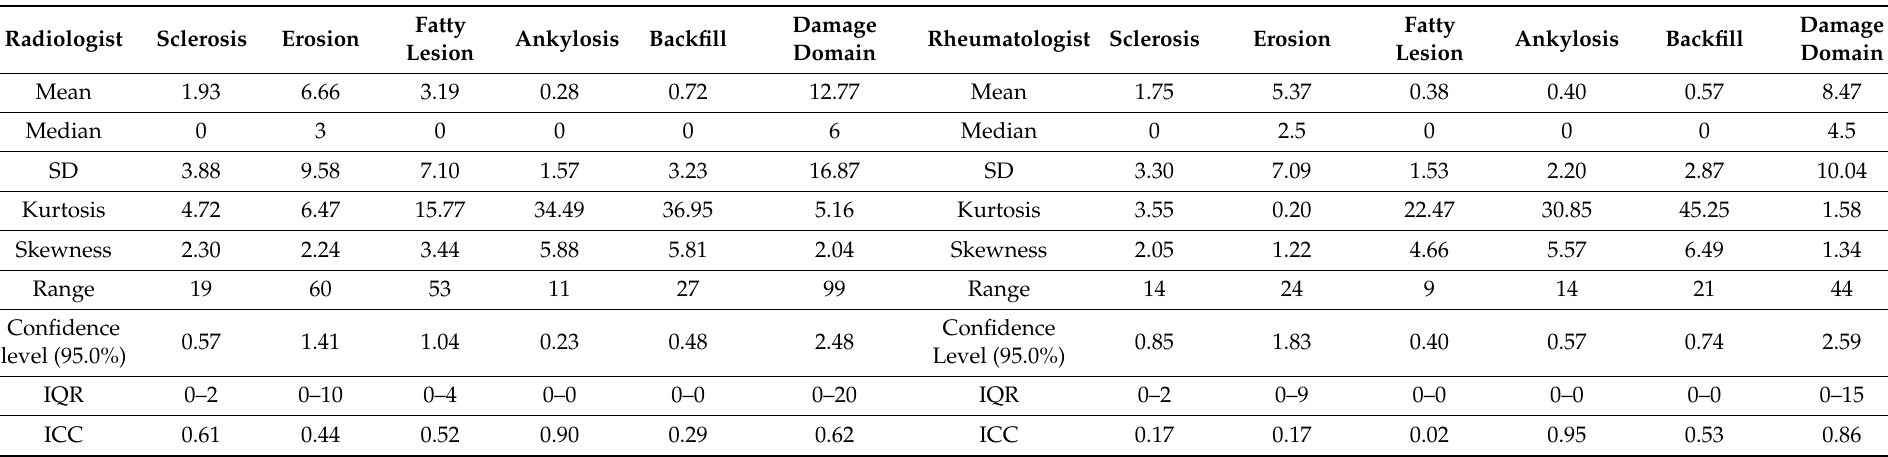
Table 4. JAMRIS-SIJ damage components’ descriptive statistic and intraclass correlation coefficients (ICCs) for six radiologists and two rheumatologists.